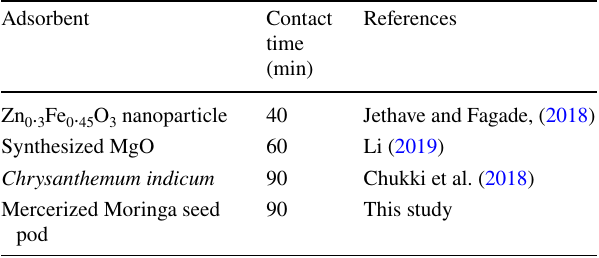
Fig. 6 Effect of contact time on dye-uptake of CR dye adsorbed from aqueous solution at different temperatures Table 2 Comparison of optimum contact time of various